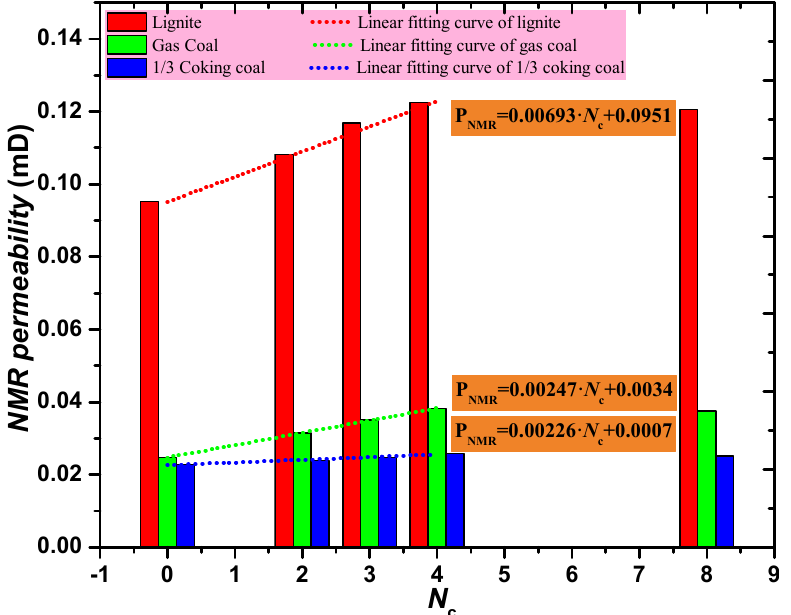
Figure 11. NMR Permeability for the three types of coal cores.